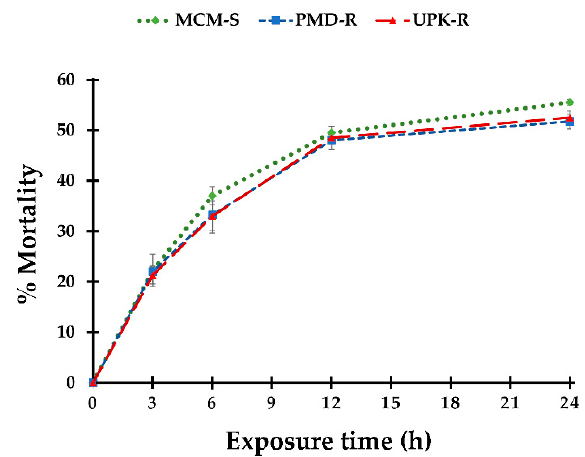
Figure 2. Threshold time for the lethal effect of exposure to LC 50 of P. crispum oil on the three strains of Ae. aegypti larvae (43.22, 44.50 and 44.03 ppm for MCM-S, PMD-R and UPK-R strains, respectively). The error bars represent the standard errors of four replicates.